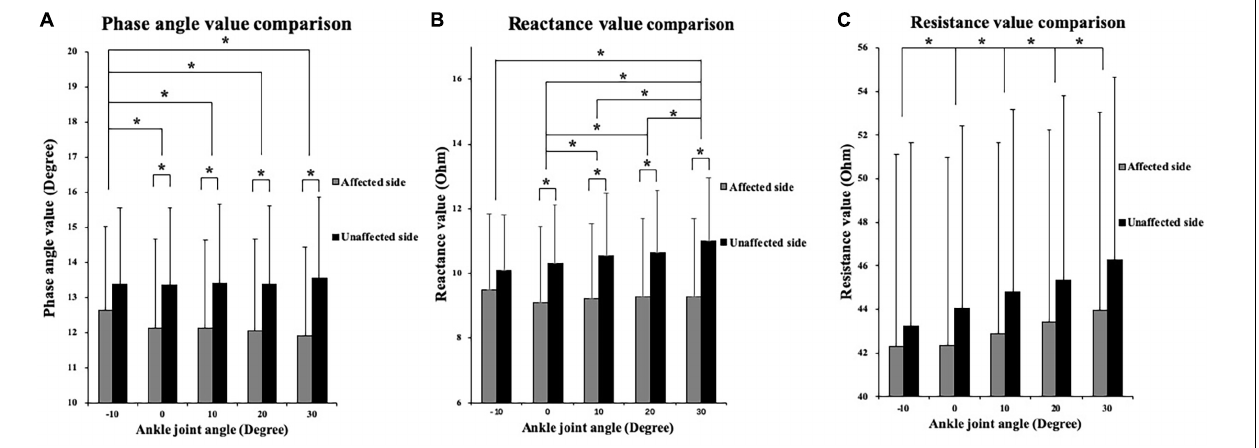
FIGURE 3 | Two-way repeated ANOVA with post hoc analysis results of EIM parameters. (A) Phase angle ( θ ) value comparison among five ankle joint angles. (B) Reactance ( X ) value comparison among five ankle joint angles. (C) Resistance ( R ) value comparison among five ankle joint angles, and significant difference was revealed between random two groups of ankle joint angles. The Y axis of A , B , and C did not start from 0 to demonstrate the variation trend of parameters versus joint angle as well as comparison between three parameters. ∗ P ≤ 0.05. ANOVA, analysis of variation; θ , phase angle; X , reactance; R , resistance; EIM, electrical impedance myography.